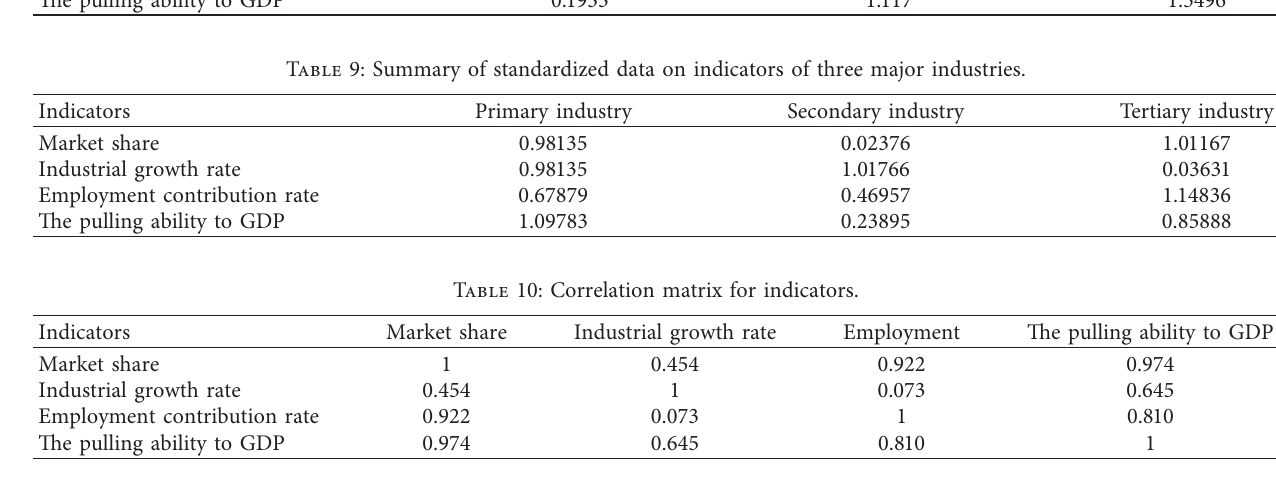
Table 11: Total variance explanation.